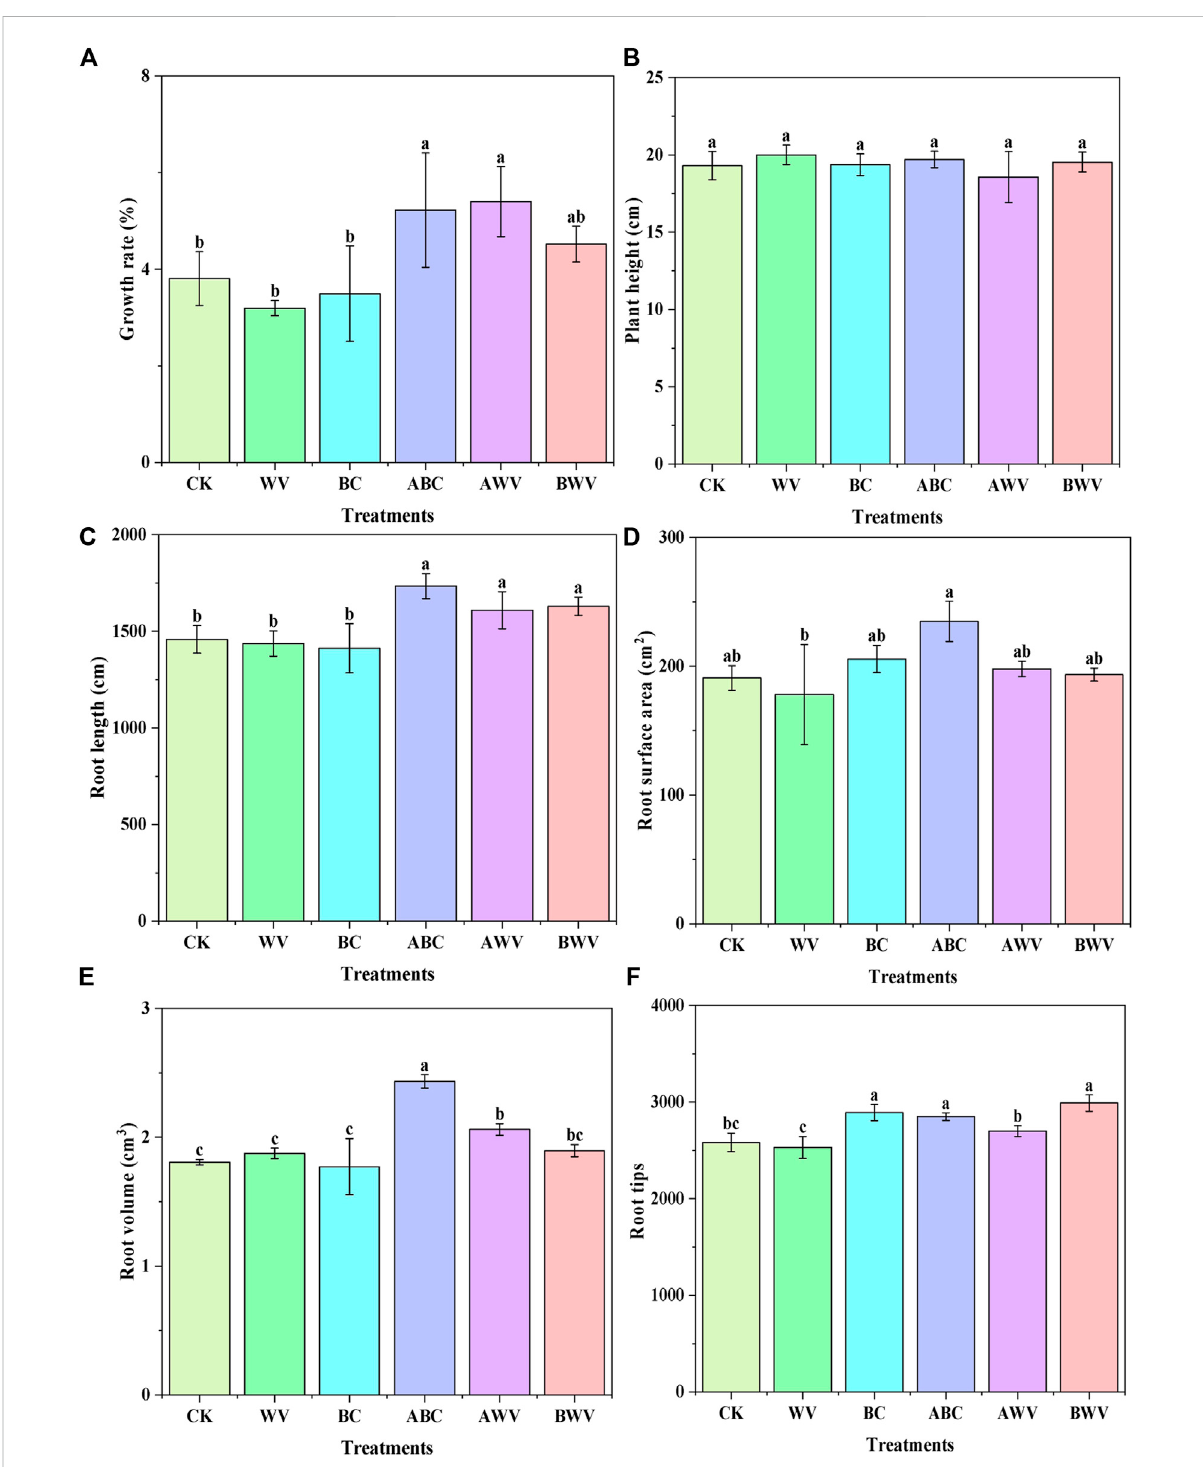
FIGURE 2 The effect of WV, BC, ABC, AWV and BWV on the Growth rate (A) , Plant height (B) , Root length (C) , Root surface area (D) , Root volume (E) and Root tips (F) of strawberry seedlings in coastal saline-alkali soil. The different letters among different treatments indicate signi fi cant differences, which were analyzed by Duncan test ( p =